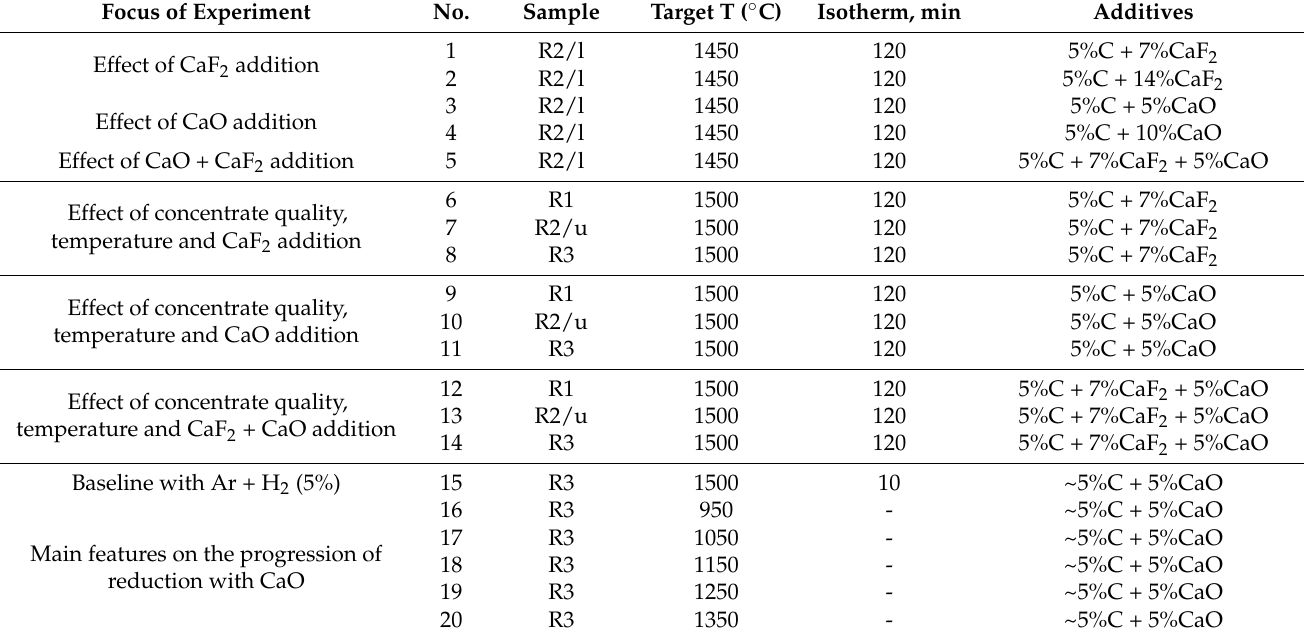
Table 1. High-temperature experimental TG program for Kiviniemi magnetic